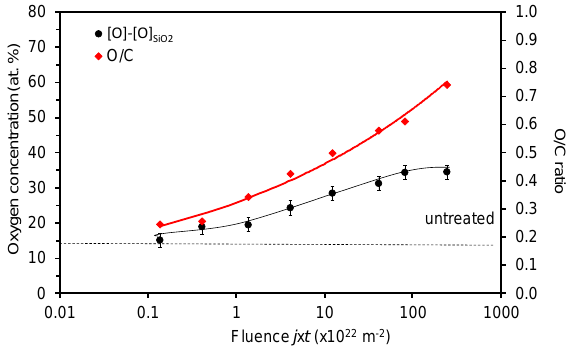
Figure 9. Silicon concentration versus O-atom fluence.